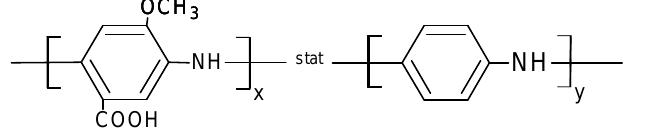
Figure 2. Chemical structure of poly(3-amino-4-methoxybenzoic acid-co-aniline) P(AMB-A).